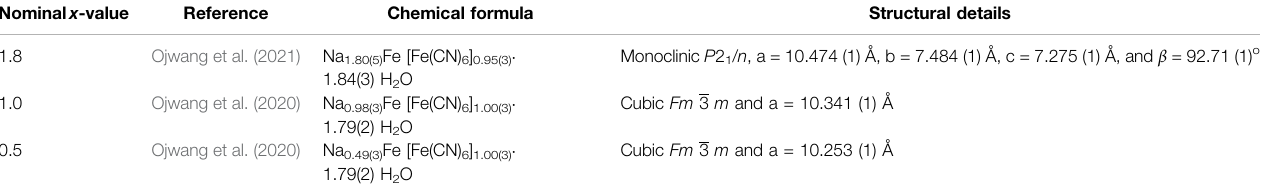
TABLE 1 | Sample compositions, structures, and original references.